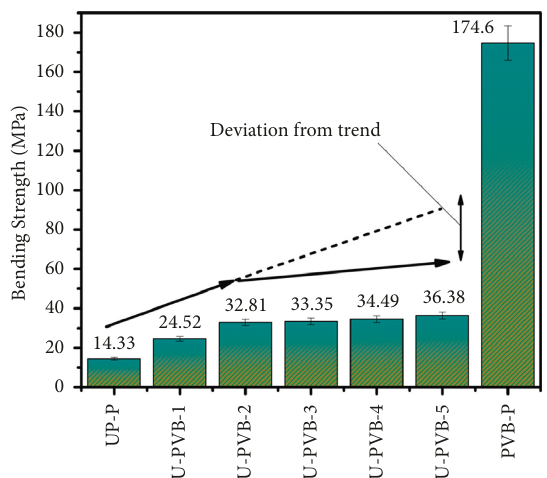
Figure 6: Flexural strength with respect to increasing PVB content.